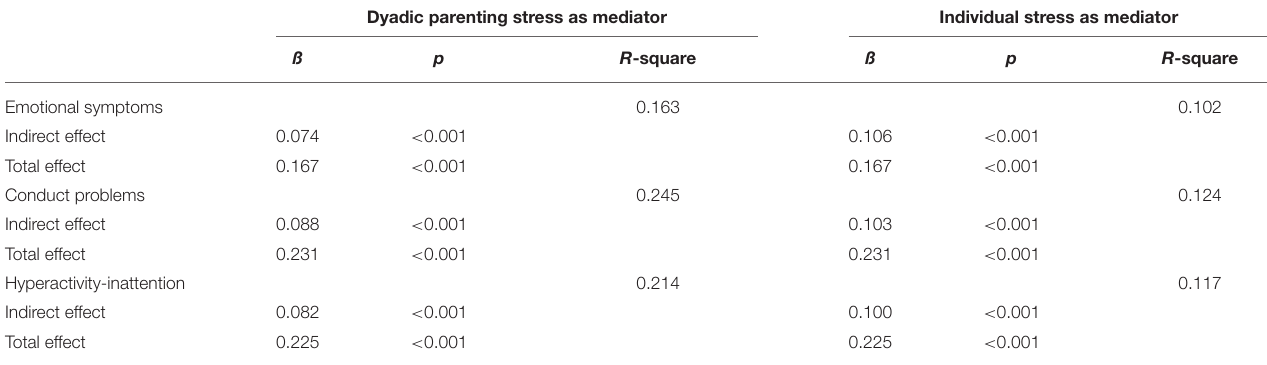
TABLE 2 | Defined parameters. Dyadic parenting stress as mediator Individual stress as